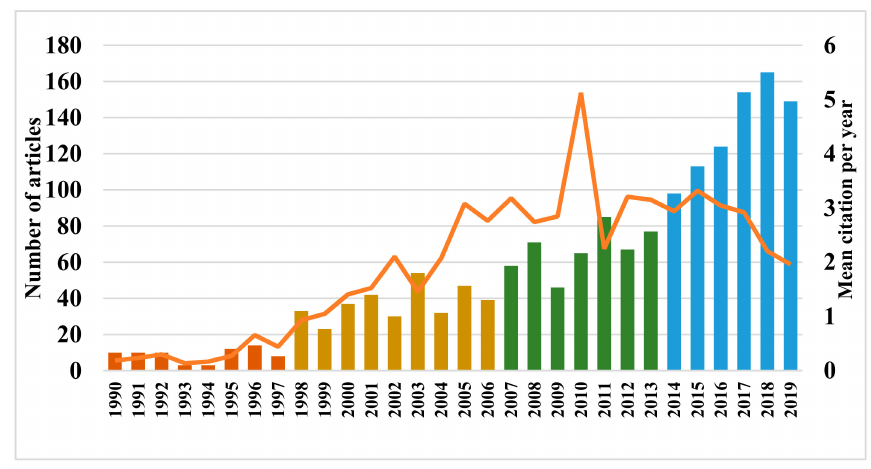
Figure 2. Number of papers and mean citation per year in the field of land use planning.